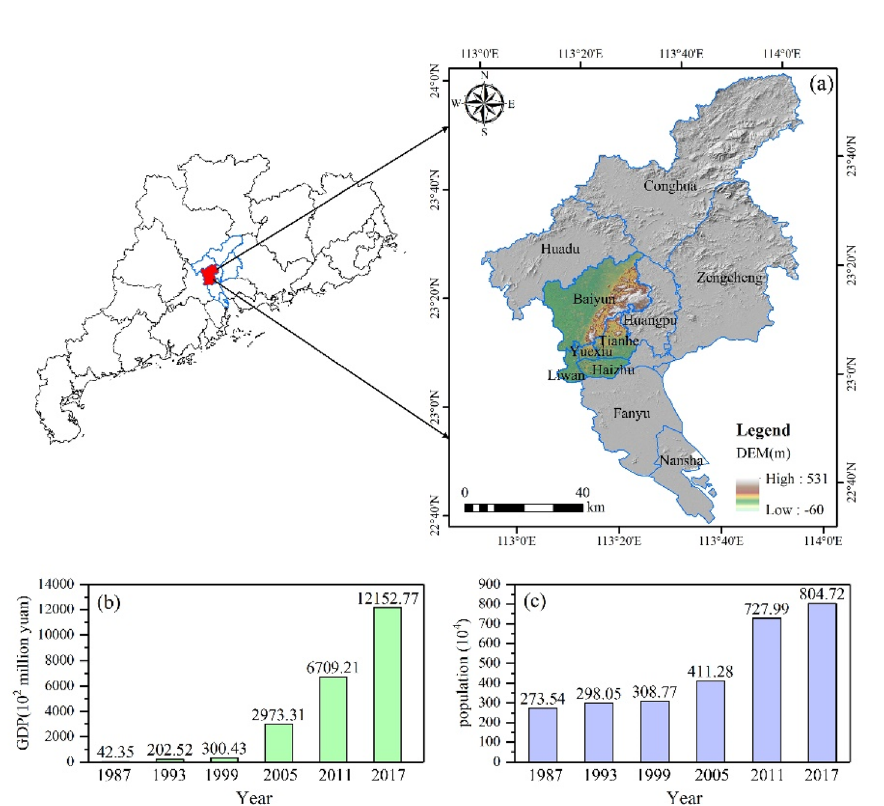
Figure 2. Location of study area and GDP and population. ( a ) location, ( b ) GDP, ( c ) population. (Software: Arc Map 10.5.0, http://www.esri.com. OriginPro 2017C SR2, https ://www.origi